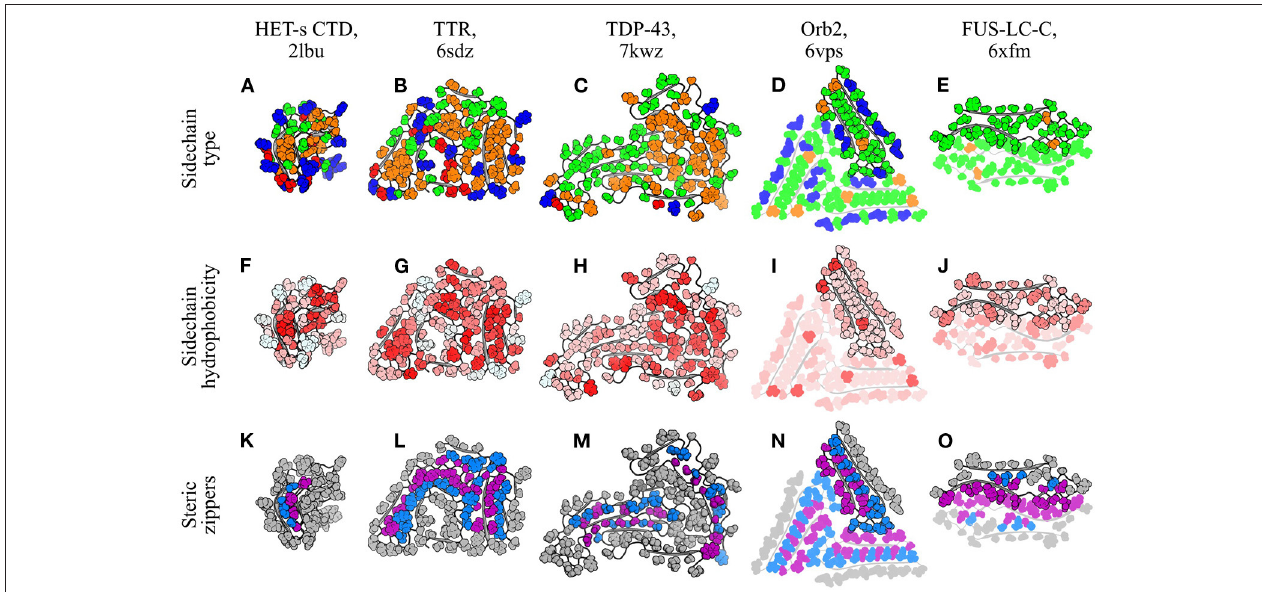
FIGURE 6 | Segregation and packing of sidechains in amyloid fibrils. Five different fibril structures are shown, organized by column: (A,F,K) , HET-s CTD (Wasmer et al., 2008 ); (B,G,L) , TTR (Schmidt et al., 2019); (C,H,M) , TDP-43 (Li et al., 2021); (D,I,N) , Orb2 (Hervas et al., 2020); (E,J,O) , FUS-LC-C (Lee et al., 2020). The name of the polypeptide is given above each structure, alongside the PDB ID. Each structure is a single subunit layer, viewed from a perspective facing down the fibril axis and using the same scale for all panels. Structures are composites of the ribbon (gray) and spheres (colored) representations, with the latter used to specifically highlight sidechains. Three different color schemes are used for sidechains, with one per row. (A–E) are colored according to sidechain type: red, negatively charged (D/E); blue, positively charged (K/R); green, hydrophilic uncharged (Q/N/S/T/Y); orange, hydrophobic (A/C/F/I/L/M/P/V/W). Histidines are colored blue or green according to the expected protonation state. (F–J) are colored according a normalized hydrophobicity scale (Eisenberg et al., 1984), with the most hydrophobic residues colored red and the most hydrophilic colored white. (K–O) are colored to highlight selected steric zippers, with sidechains in zipper-forming strands alternately colored either blue or purple, so that the two halves of each intra-protofilament zipper are colored differently. For the purpose of this figure, a steric zipper is defined as a chain segment whose sidechains are buried in the fibril core and interdigitated between the sidechains of an opposing chain segment. This includes cases varying from a relatively low [e.g., (K) ] to a high [e.g., (N) ] level of interdigitation, and reflects the fact that steric zippers, as defined here, exist on a continuum rather than having a simply defined cut-off. For clarity, only some of the zipper segments have been highlighted for TDP-43. For the Orb2 and FUS-LC-C structures, which have multiple protofilaments, additional protofilaments are shown with semi-transparent rendering, to aid in discrimination between protofilaments and identification of inter-protofilament steric zippers. Note that FUS-LC-C contains an inter-protofilament homo-zipper, which is formed by identical chain segments from either side of the protofilament binding interface, and has the same color for each half of the